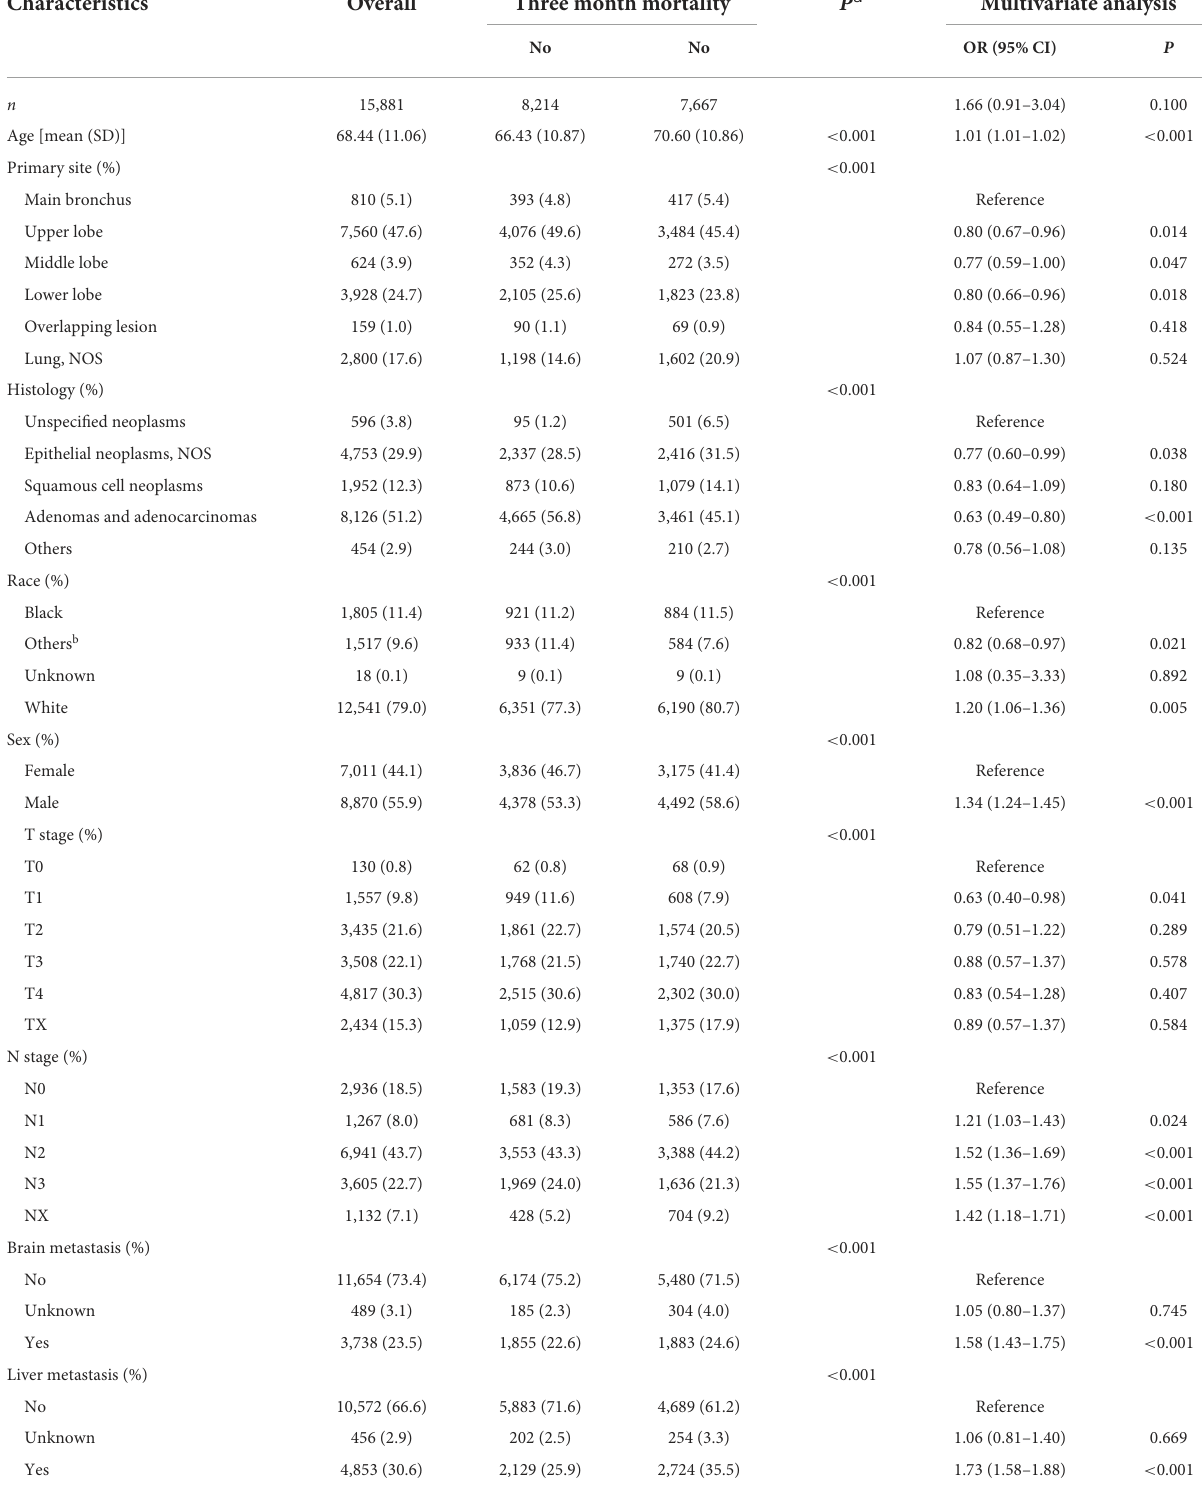
TABLE 2 Univariate and multivariate analysis of risk factors for 3 month mortality among bone metastasis patients with lung cancer in the training group. Characteristics Overall Three month mortality P a Multivariate